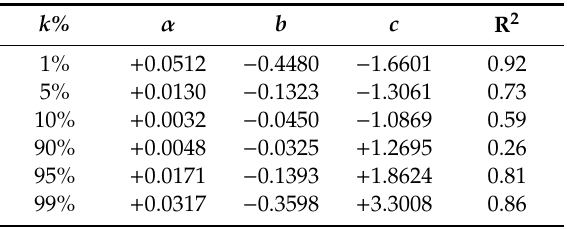
Table 2. Parameters of a , b, and c to estimate N k%